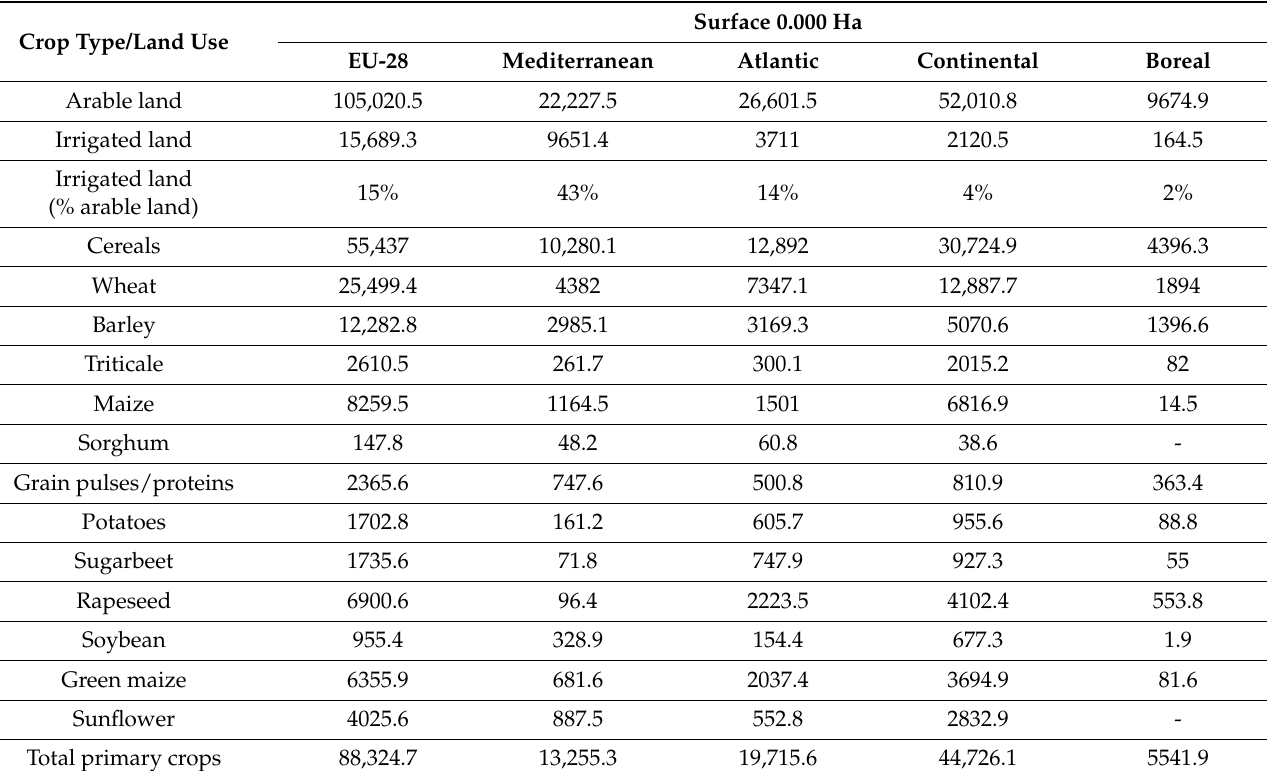
Table 1. Surface area of primary crops, Eurostat